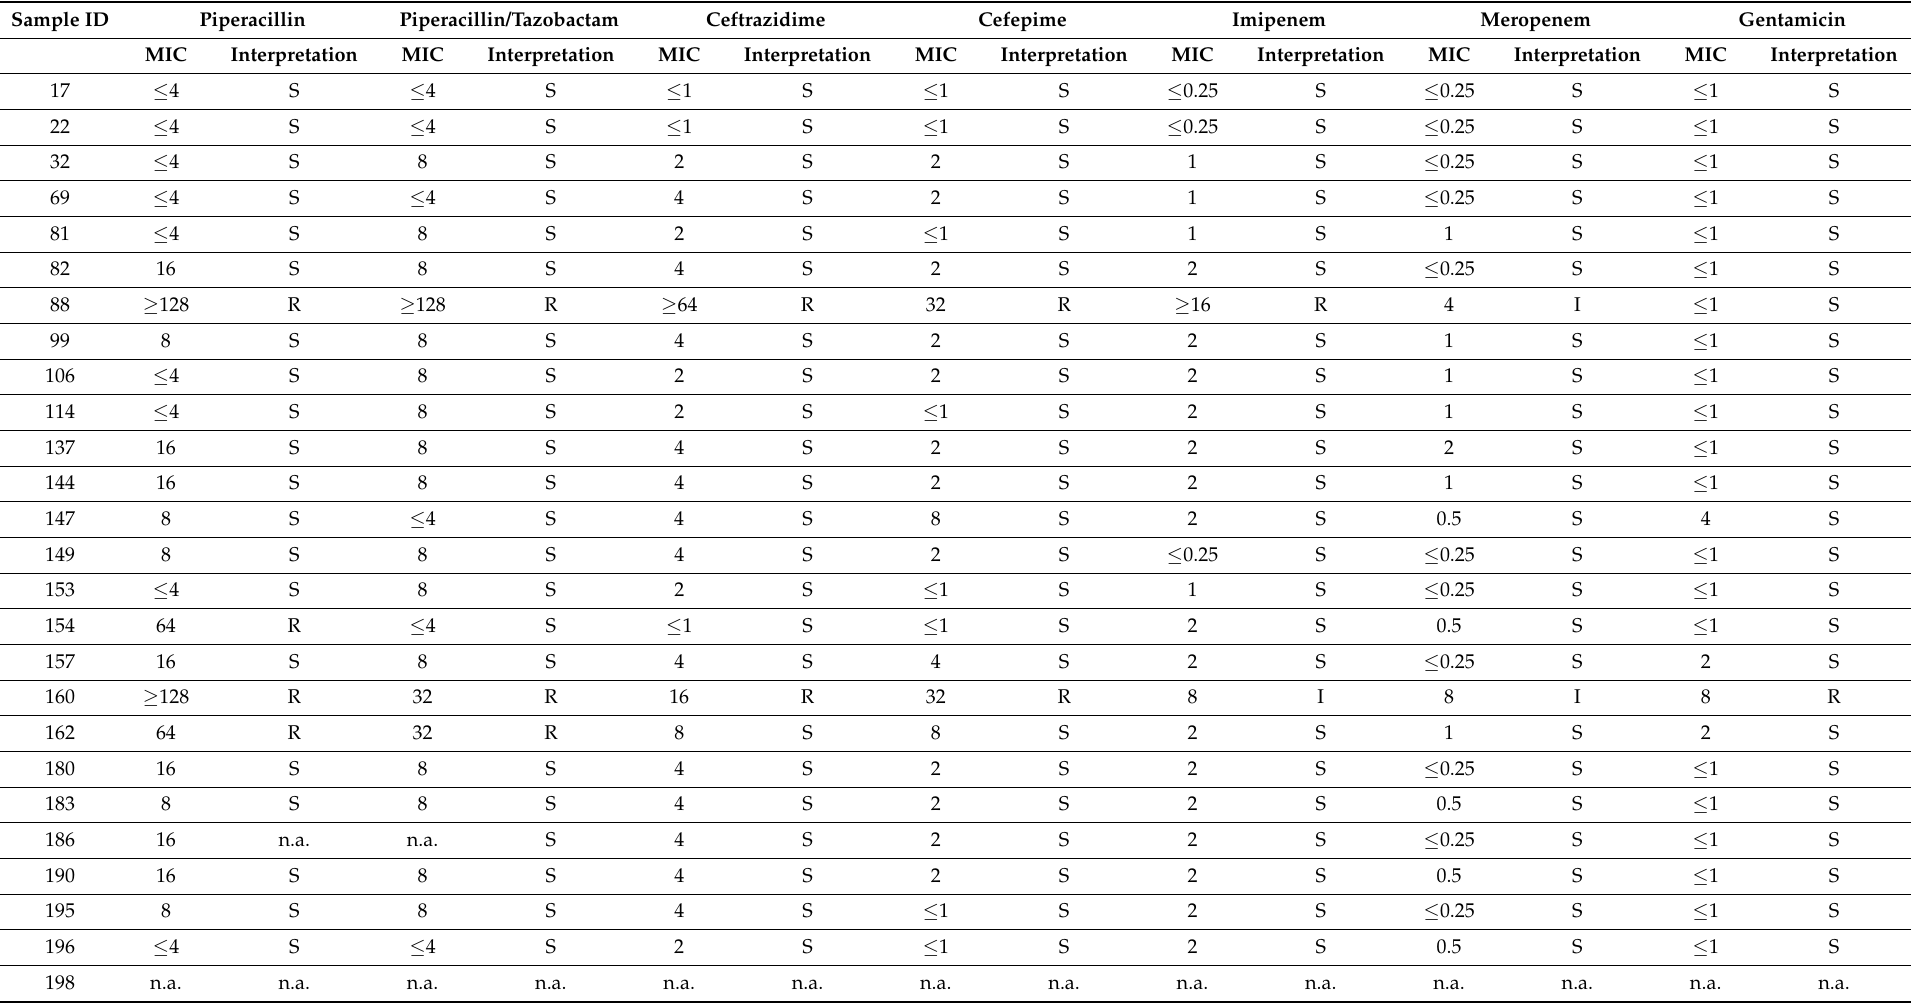
Table A3. Phenotypic resistance the P. aeruginosa strains. Data are missing for strains 198, 218 and 312, due to loss during subcultivation. MIC = minimum inhibitory concentration. N.a. = value missing due to loss of strain or failed